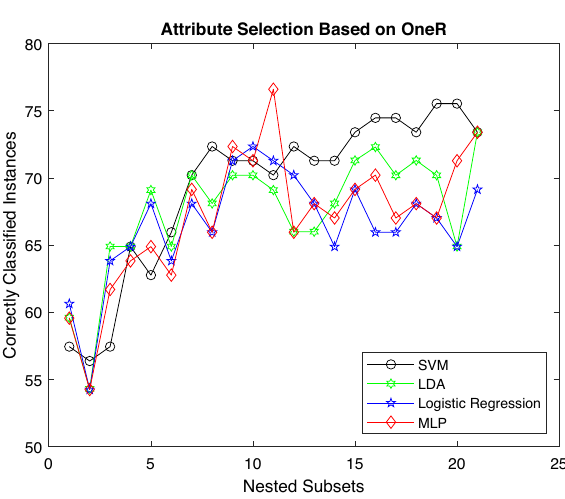
Figure 7. Accuracy of various classifiers depending upon